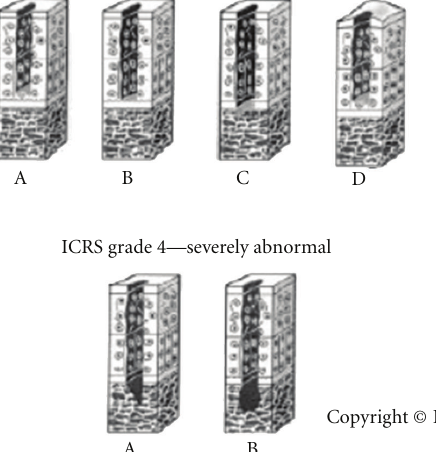
Figure 2: The International Cartilage Repair Society (ICRS) Cartilage Lesion Classification System. Reprinted with permission from the ICRS Cartilage Injury Evaluation Package